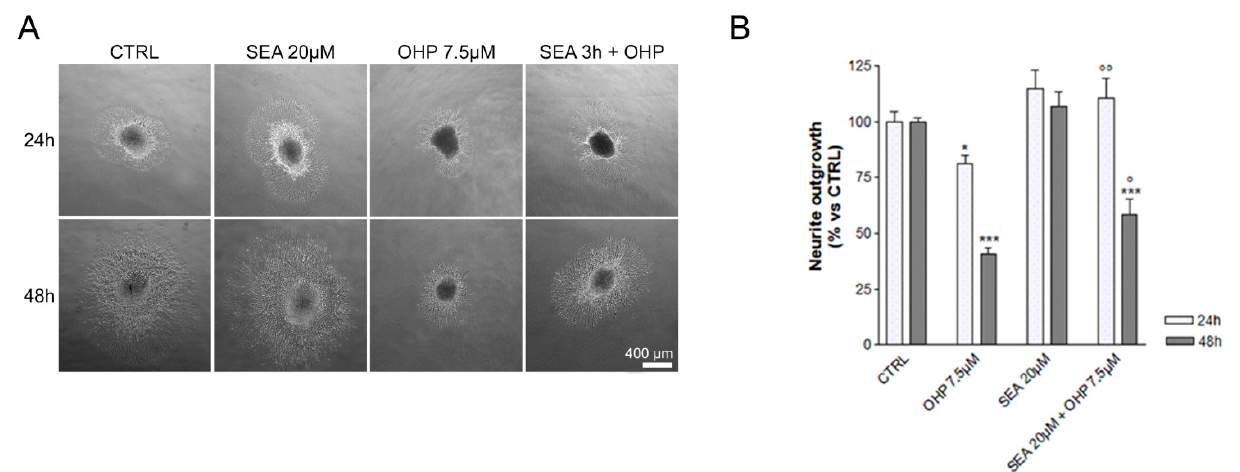
Figure 1. In vitro experiment results. ( A ) shows representative images of neurite elongation at 24 and 48 h (upper and lower panel, respectively); CTRL: control group; SEA: SEA0400-treated; OHP: Oxaliplatin-treated. ( B ) shows neurite outgrowth as a percentage respect to the CTRL group (statistical significance of one-way ANOVA (followed by Tukey’s Multiple Comparison Test) is also provided: * p < 0.05 vs. CTRL; *** p < 0.001 vs. CTRL; ° p < 0.05 vs. OHP, °° p < 0.01 vs. OHP).